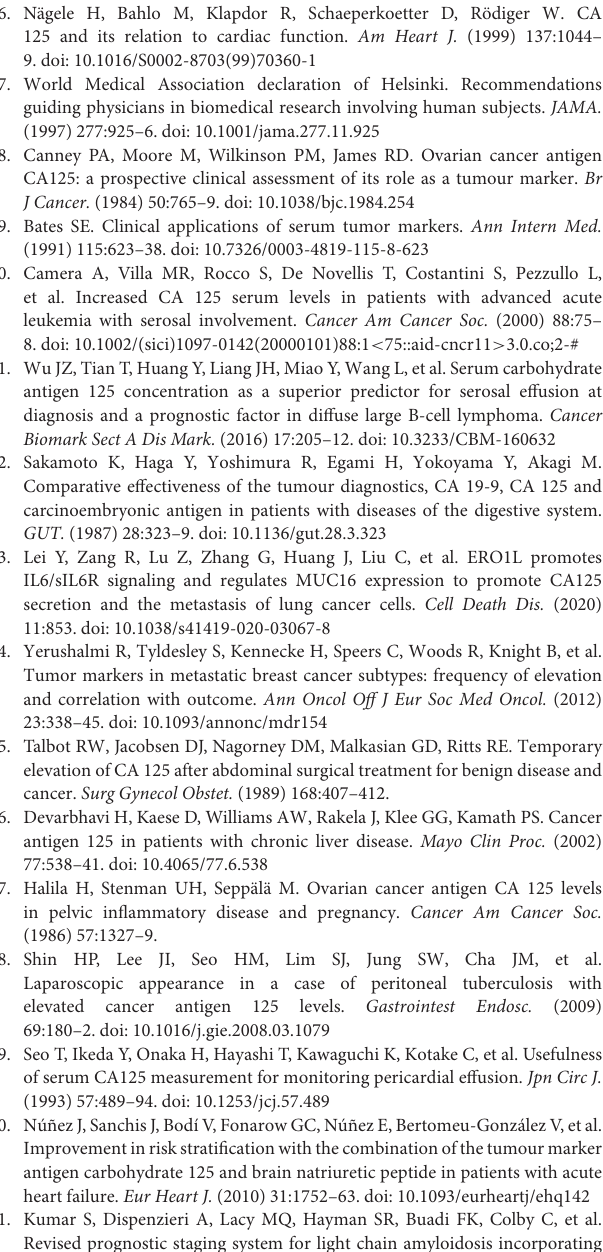
Supplementary Table 1 | Clinical characteristics of several control